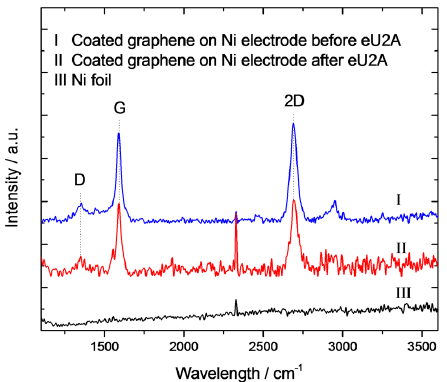
Figure 6. Raman spectra of graphene-coated Ni before (curve I) and after (curve II) 24 hours’ eU2A experiment and bare Ni foil (curve III).